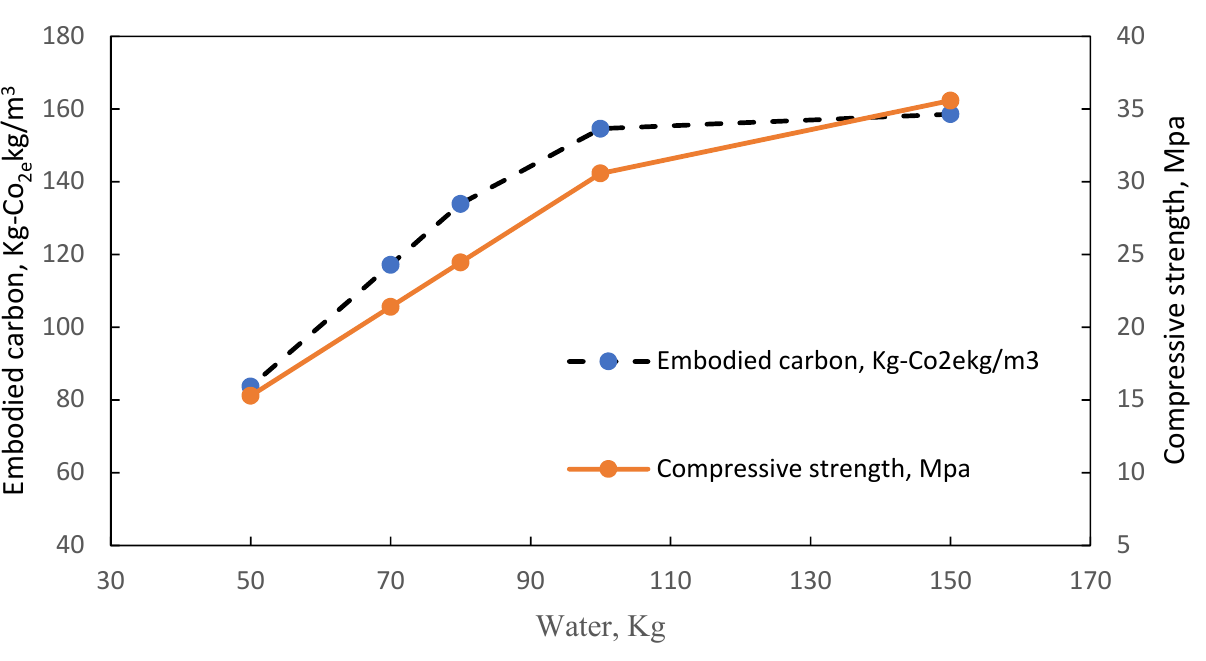
Figure 12. LCC at optimal water content of 130-150 litres per m 3 of concrete Batch A [32].